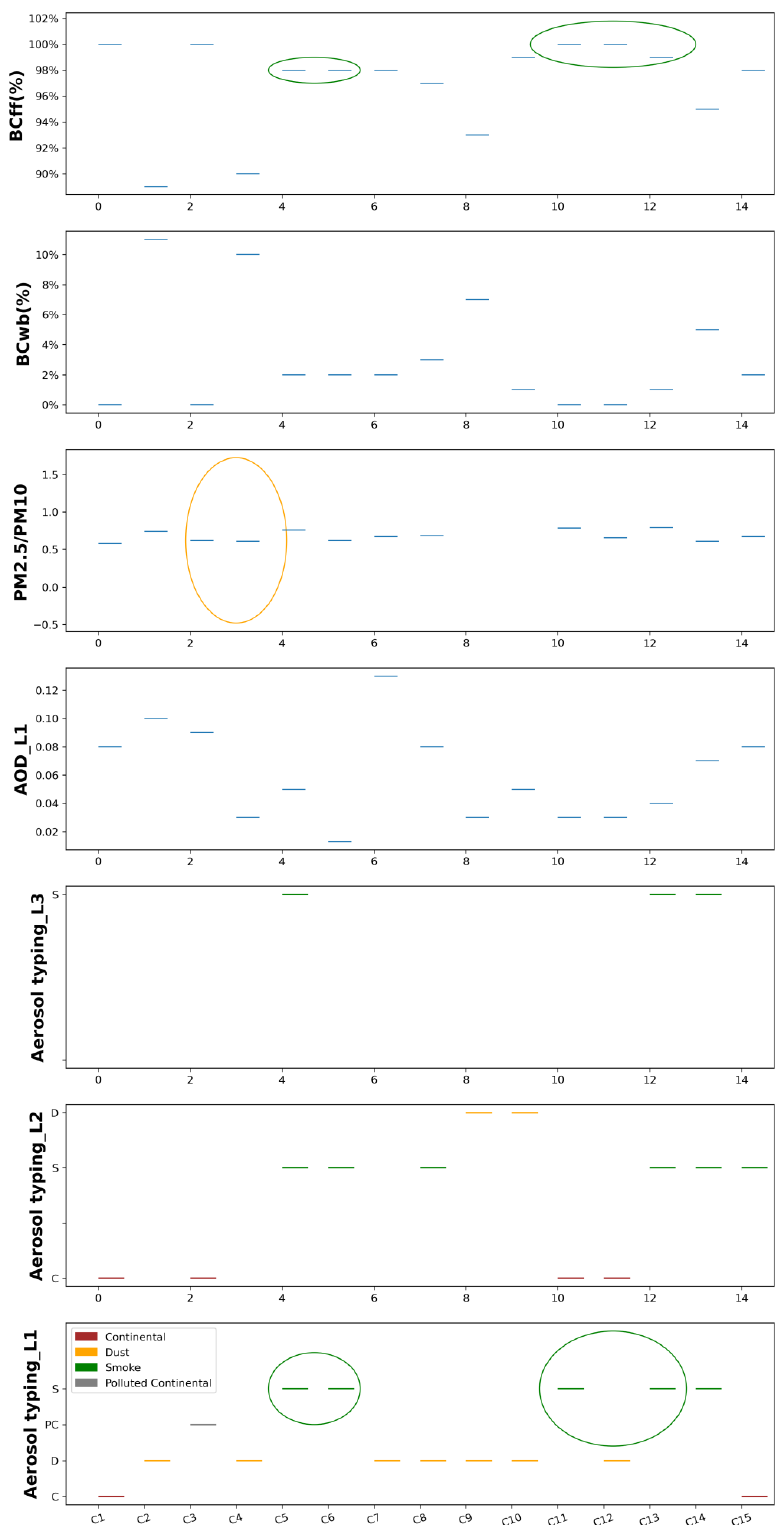
Figure 8. Black Carbon contribution of the fossil fuel and the biomass/wood burning, along with the PM2.5/PM10 ratio and the optical thickness (of the first layer) and the aerosol typing of up to three detected layers over Thessaloniki during the PANACEA campaigns are presented. In total 15 cases (C#) have been identified (days with simultaneous measurements with THELISYS, MP101M and Aethalometer).